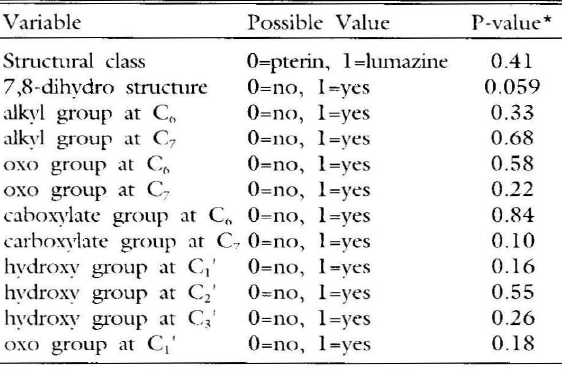
Table I . Coding of stmctural features of the pteridines studied, and their association with the inhibition of cyto